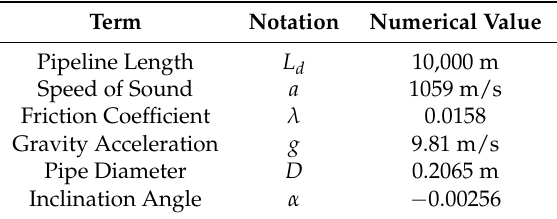
Table 1. Pipeline